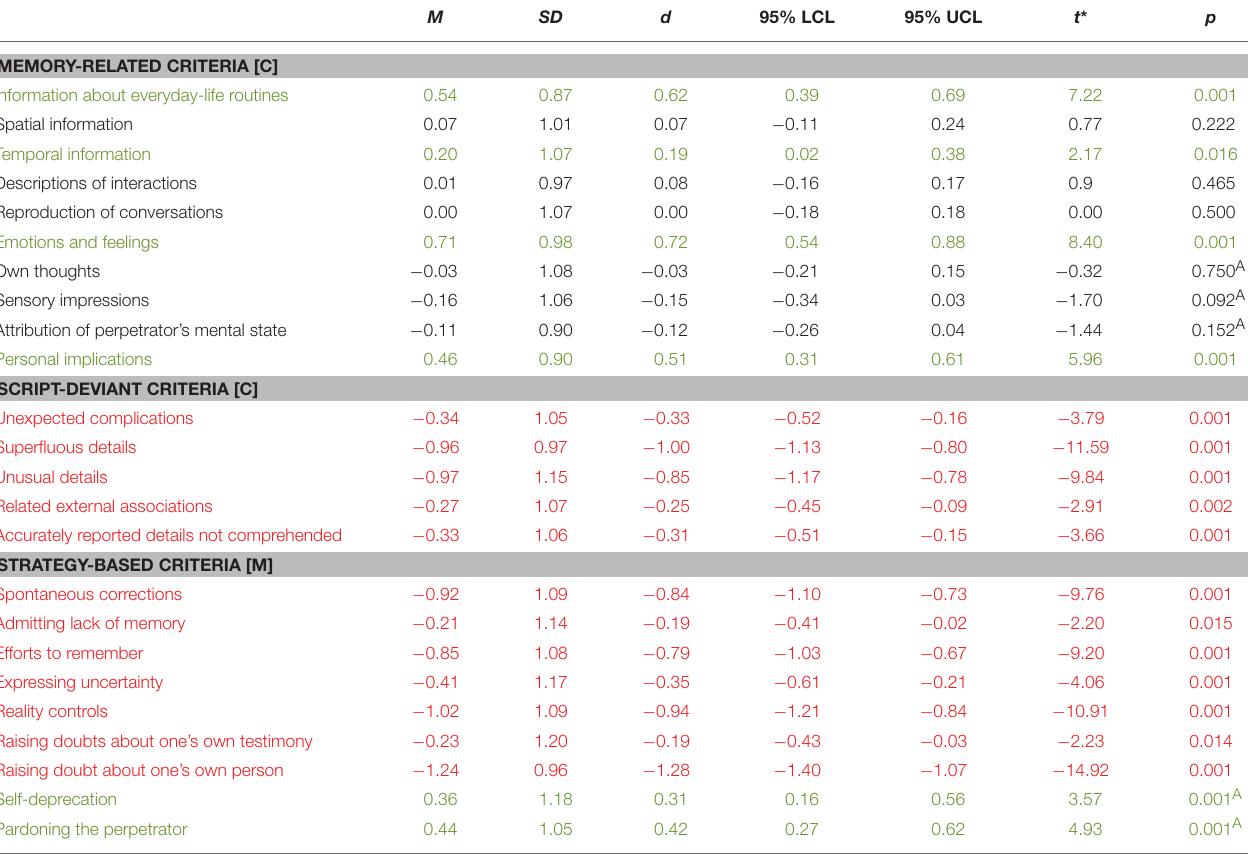
* N = 135; df = 134. LCL, Lower confidence limit; UCL, Upper confidence limit; [C], Cognitive criteria; [M], Motivational criteria. Criteria in green font color received significant positive value ratings, while criteria in red font color symbolize significant negative ratings. A For results contradictory to our hypotheses the p-values from two-tailed tests were reported. Otherwise, the p-values were derived from one-tailed tests, since the testing hypotheses were one